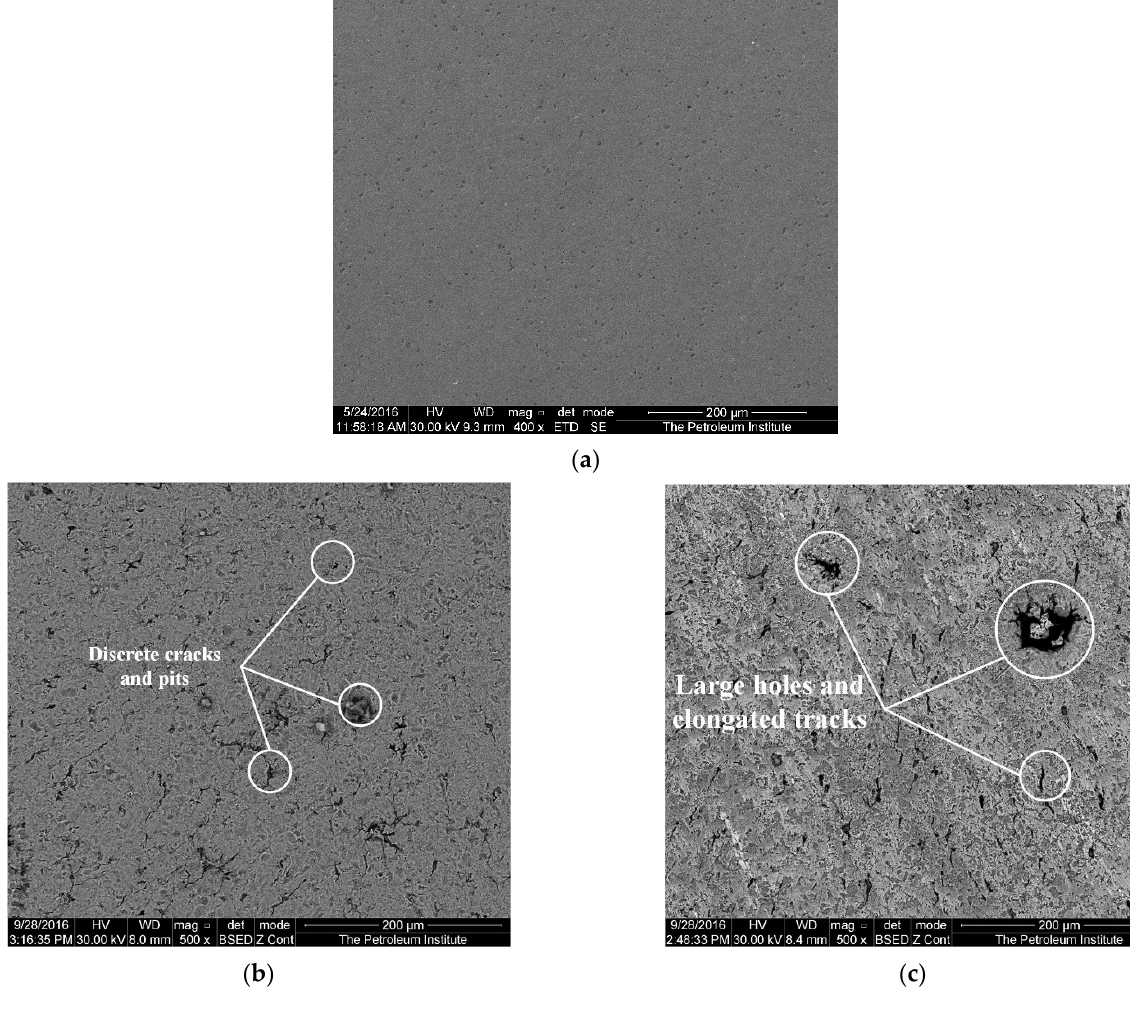
Figure 5. Surface of the specimen central zone: ( a ) parent metal, after impingement test at 20 m/s and 600 mg/L; ( b ) after 1 h; and ( c ) after 4 h. and 600 mg/L; ( b ) after 1 h; and ( c ) after 4